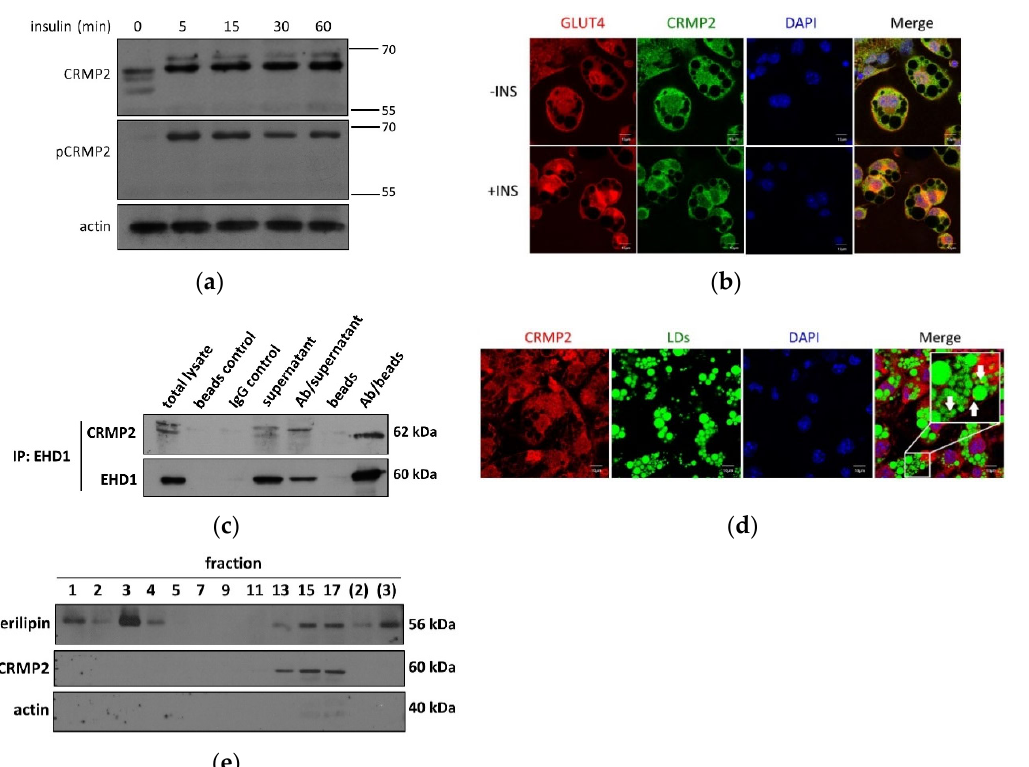
Figure 4. CRMP2 expression profile, GLUT4 and lipid droplets. ( a ) CRMP2 and pCRMP2 were ana ‐ lyzed by Western blotting in pre ‐ adipocytes. ( b ) Confocal microscopy analysis of CRMP2 and GLUT4 localization in mature adipocytes without ( ‐ INS, upper panel) and with (+INS, lower panel) insulin treatment. ( c ) Anti ‐ EHD1 ‐ precipitated protein complexes in adipocyte lysates were immunoblotted with anti ‐ CRMP2 and anti ‐ EHD1. ( d ) CRMP2 and LDs in adipocytes were analyzed by confocal microscopy. ( e ) Adipocyte lysates were subcellularly fractionated, followed by Western blotting using perilipin as LD marker. Fractions (2) and (3): white aggregates from fractions 2 and 3. Images were obtained with Zeiss LSM700 confocal microscope using 63X objective, scale bar = 10 μ m ( n = 3).